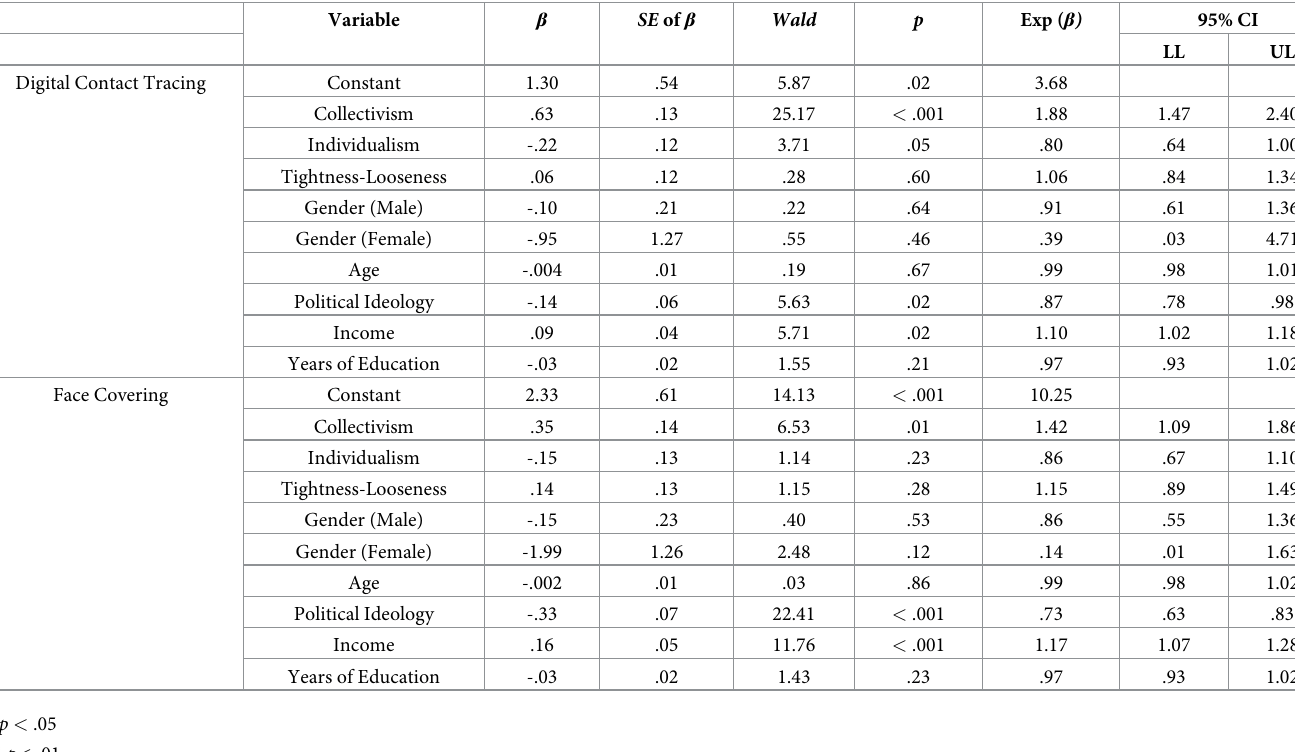
Table 5. Collectivism predicts compliance to health